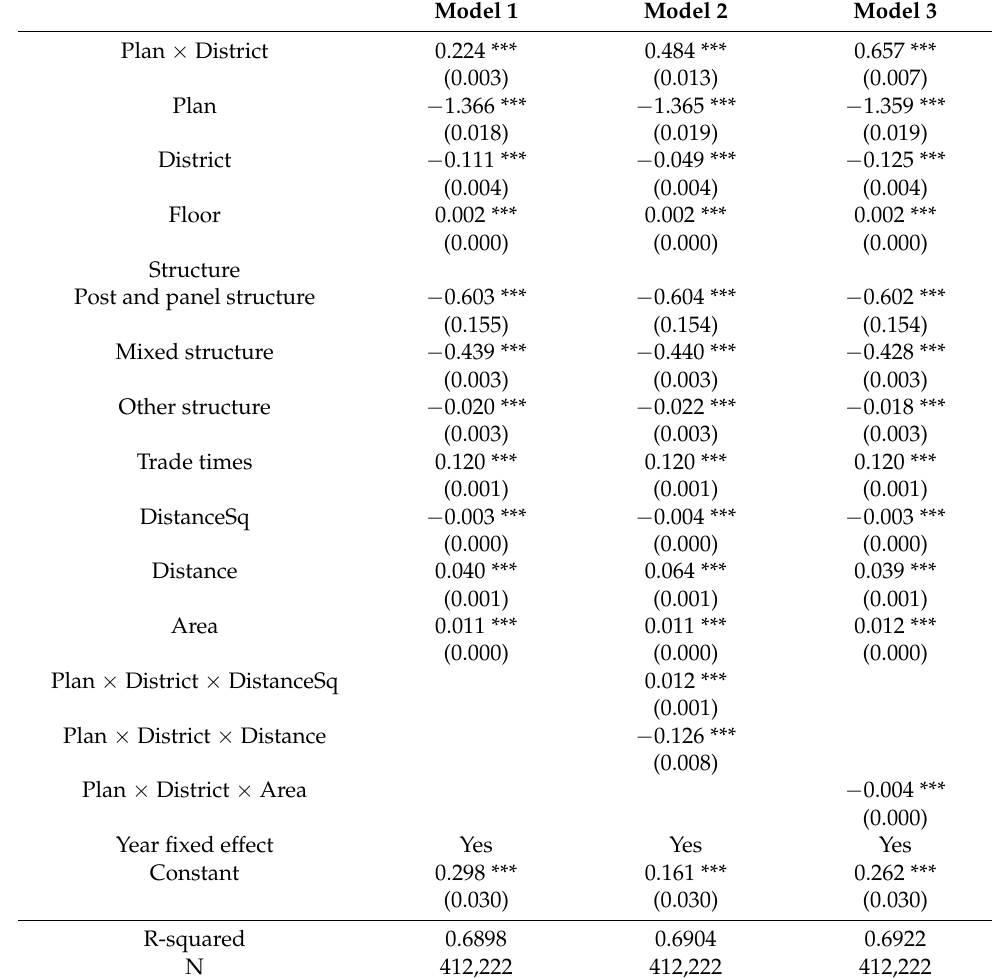
Table 4. Impact of the construction of the National Big Data (Guizhou) Experimental Area on transaction